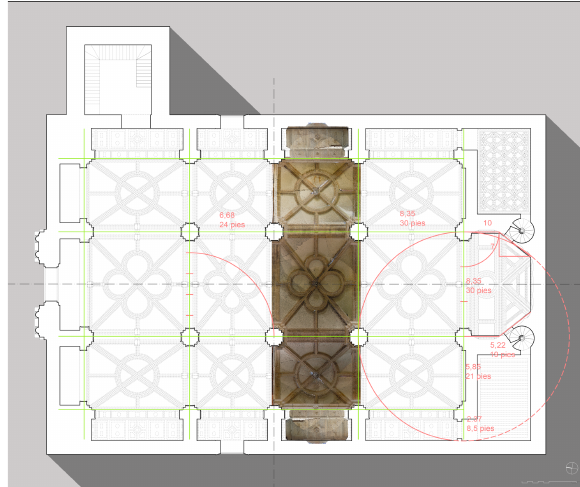
Figure 8. Floor plan with analytical drawings of the church produced using BIM.